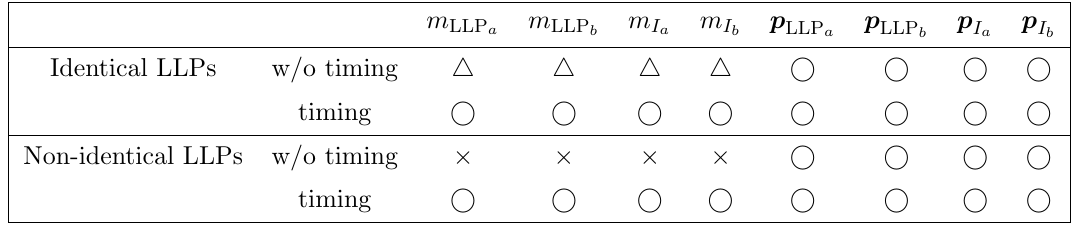
Table 1 . Summary of reconstruction scenarios. The mark (cid:13) ( (cid:2) ) indicates whether the system can (cannot) be reconstructed. The triangle ( 4 ) indicates that the system can be reconstructed but with 2-fold